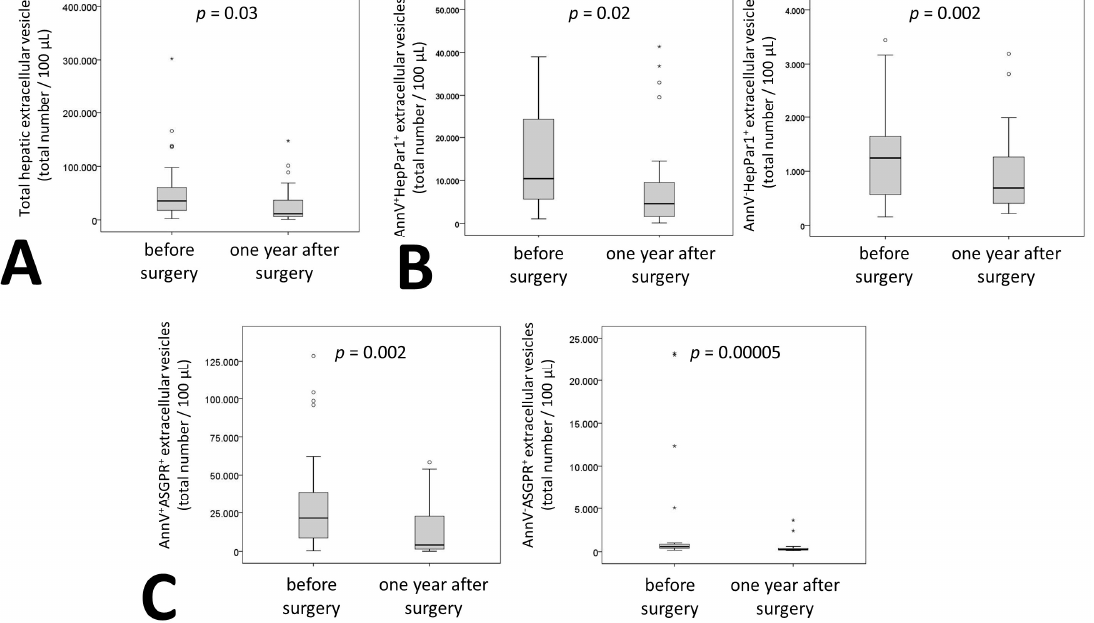
Figure 2. Extracellular hepatic vesicle dynamics in patients undergoing bariatric surgery. ( A ): Total hepatic medium extracellular vesicles in citrated plasma of 27 patients before and one year after surgery were defined as HepPar1 + , asialoglycoprotein receptor (ASGPR) + , and HepPar1 + ASGPR + medium extracellular vesicles using flow cytometry. HepPar1 + ( B ) or ASGPR + ( C ) medium extracellular vesicles in citrated plasma of 27 patients before and one year after surgery were evaluated for their AnnV staining pattern. Absolute numbers of extracellular vesicles positive for AnnV + and AnnV – were determined by flow cytometry. Values are given per 100 µ L of plasma. For (A–C) a Wilcoxon test was used. p ≤ 0.05 was considered significant.